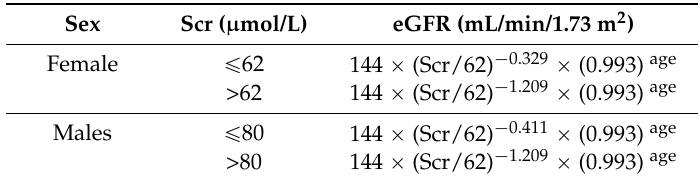
Table 1. The definition of estimated glomerular filtration rate (eGFR) based on creatinine level was calculated by Chronic Kidney Disease Epidemiology